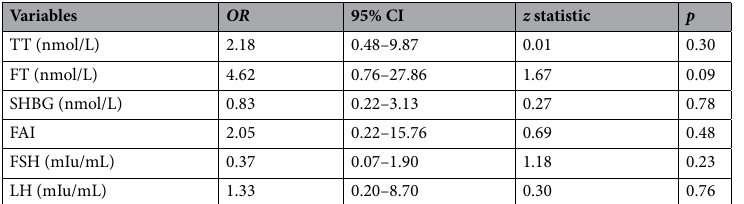
Table 3. Association of sexual health inventory for men in post-COVID-19 patients with erectile dysfunction. TT total testosterone, FT free testosterone, SHBG sex hormone-binding globulin, FAI free androgenic index, FSH follicular stimulating hormone, LH luteinizing